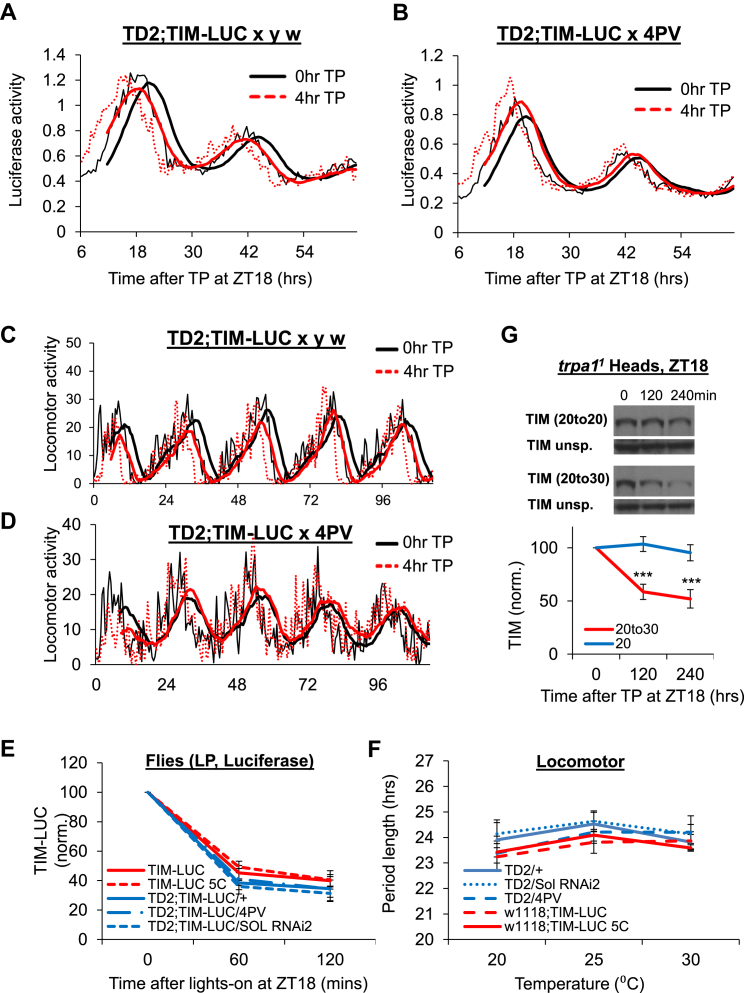
Ca2+ Mediates Circadian Phase Shifts, Related to Figure 2(A and B) Representative average luciferase recordings of 6 control (non-pulsed, black) or temperature-pulsed (red) flies with corresponding 6 hr moving average traces are shown. TIM-LUC flies expressing various transgenes were housed individually in wells in a 96-well plate and luciferase activity was measured. A 4 hr TP was applied at ZT18 after three days of entrainment to a 12/12 LD cycle. Same paradigm was used for Figures S2-S4. Flies from crosses to y w (A) are used as controls and show ca. 3 hr advance in response to TP, while PV (B) show much reduced shifts.(C and D) Representative average locomotor behavior recordings of 8 control (non-pulsed, black) or temperature-pulsed (red) flies with corresponding 6 hr moving average traces are shown after a 4 hr TP which was applied at ZT18. Same paradigm was used for Figures S2-S4. Flies from crosses to y w (C) are used as controls and show ca. 2 hr advance in response to TP, while PV (D) show much reduced shifts.(E) Light given at ZT18 degrades TIM normally in flies expressing the TIM-LUC, TIM-LUC 5C mutant, SOL RNAi or PV in vivo.(F) Flies expressing TIM-LUC 5C mutant, SOL RNAi or PV have normal temperature compensation. Locomotor activity rhythms from at least 30 flies per genotype were recorded at 20, 25 and 30°C in DD and average period lengths from at least four independent experiments are shown. Error bars: SEM for (E-F) from at least four independent experiments (n ≥ 6 each) is shown.(G) Thermal TIM degradation is not affected in trpa11 flies. Temperature shift (TS) and non-pulsed control (cnt) from 6 independent experiments.